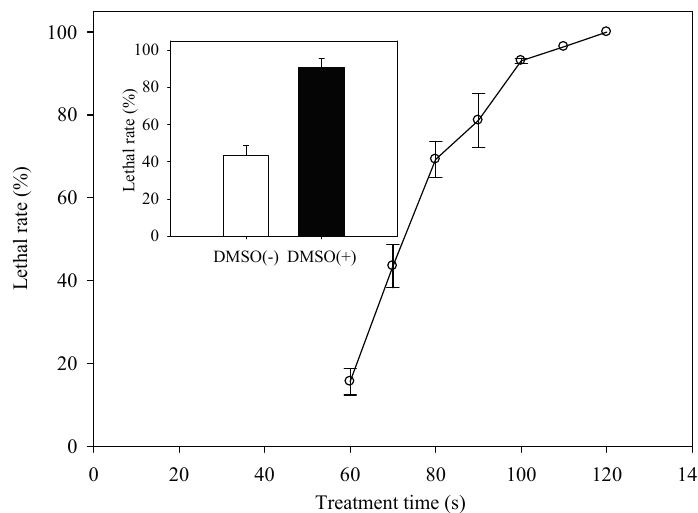
Figure 2. The relationship between treatment conditions of ARTP and lethal rate of C. cohnii . The curve representing lethal rate against treatment time; the white column: the lethal rate of cells diluted by By+ medium without dimethylsulfoxide (DMSO) treated for 70 s; the black column: the lethal rate of cells diluted by By+ medium with DMSO treated for 70 s; the irradiation conditions: C. cohnii sampled at 36 h, RF power input of 150 W, helium gas flow rate of 10 L/min, distance between the C. cohnii cells and the plasma source of 2 mm.